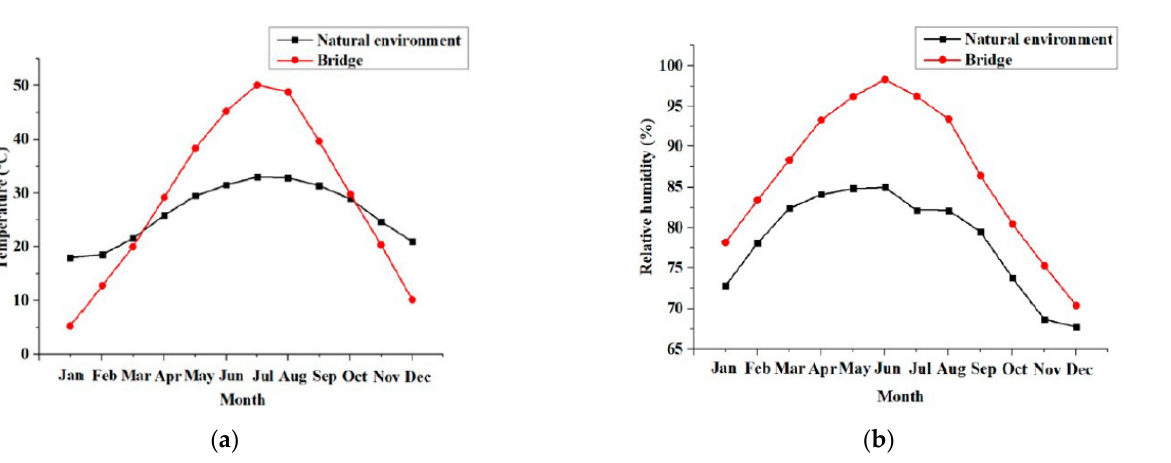
Figure 3. Recorded data for Guangzhou, China: ( a ) temperature; ( b ) relative humidity (Adapted from Ref. [33]).